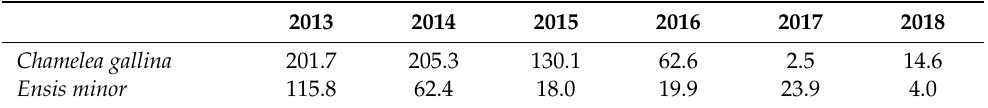
Table 3. Production (tons) of striped Venus ( Chamelea gallina ) and razor clam ( Ensis minor ) in the Maritime Compartment of Monfalcone (2013–2018)